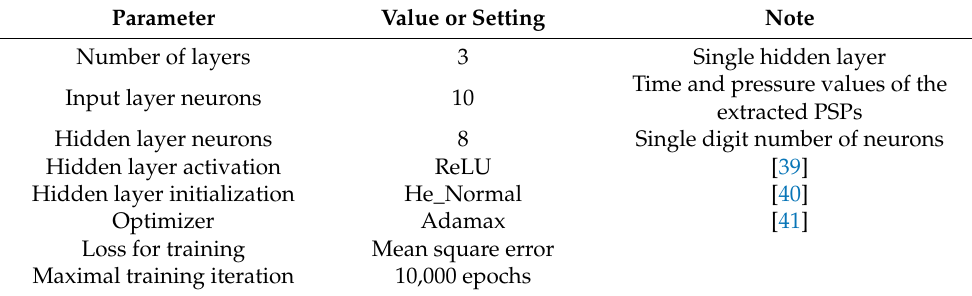
Figure 7. Structure of the multi-layer perceptron with fully connected neurons. Table 3. MLP architecture.